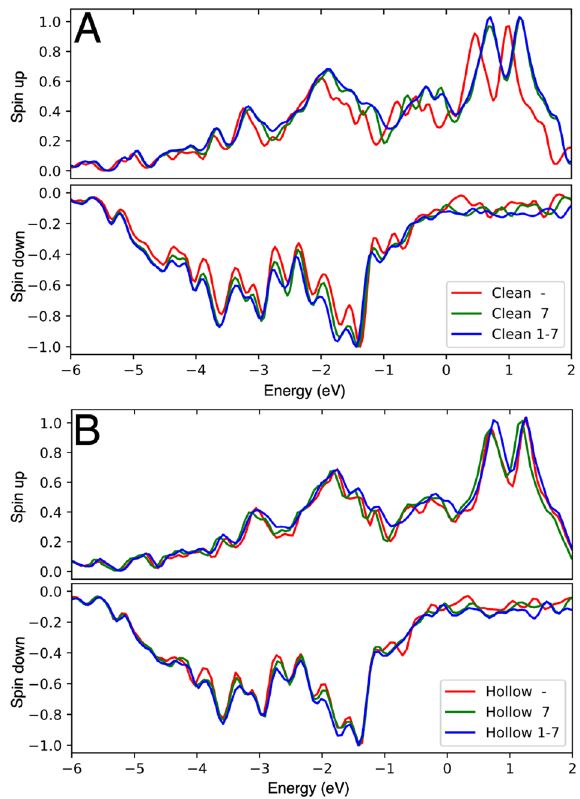
Figure 5. DOSes (positive values for up and negative values for down spin channels) for ( A ) an oxygen- free surface with zero (red), one (green) or two (blue) Cr atoms corresponding to the strongest binding configuration; ( B ) as ( A ) but with an oxygen atom at the hollow site. The horizontal axis is energy in eV relative to the Fermi energy, and the vertical axis is the DOS in arbitrary units. The numbers in the legends indicate the position(s) of the Cr atom(s) (see Fig. 1 for the numbering scheme). The lone hyphen indicates the absence of Cr atoms in the